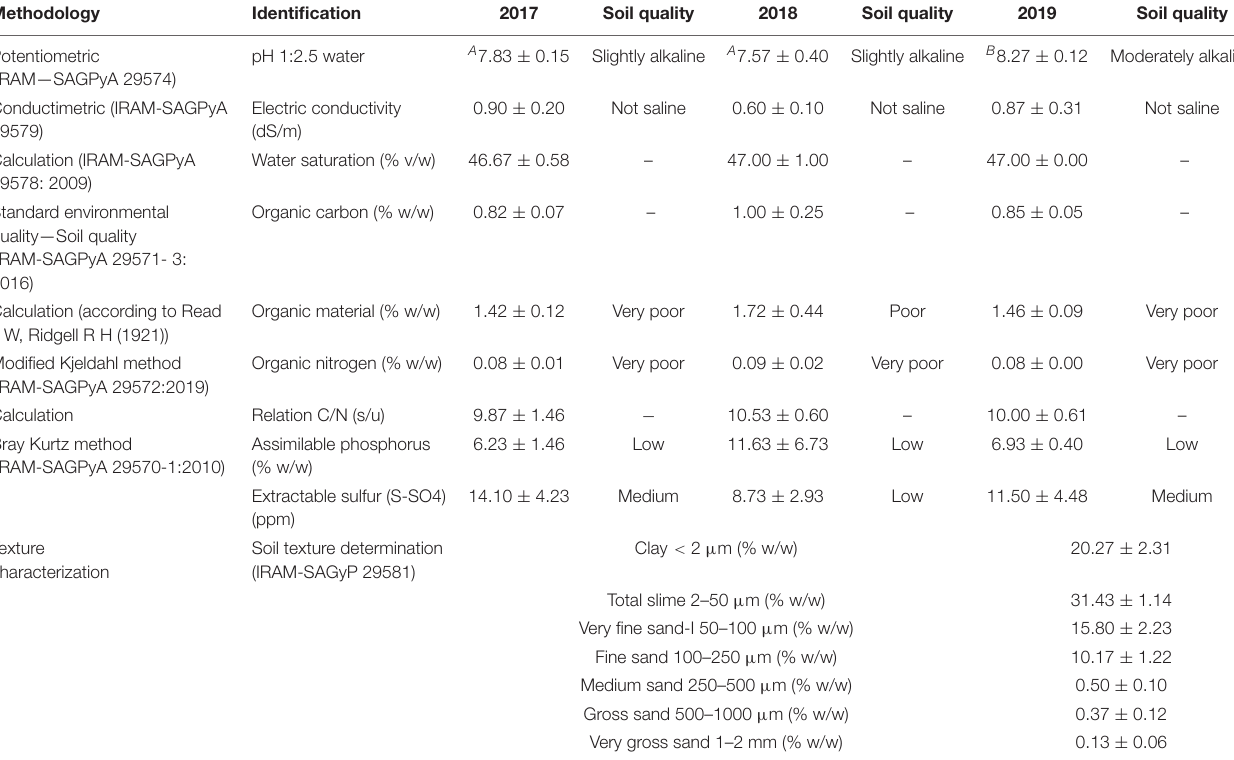
TABLE 1 | Chemical and texture characterization of the Saldungaray’s soil from the three consecutive vintages analyzed (2017, 2018, and